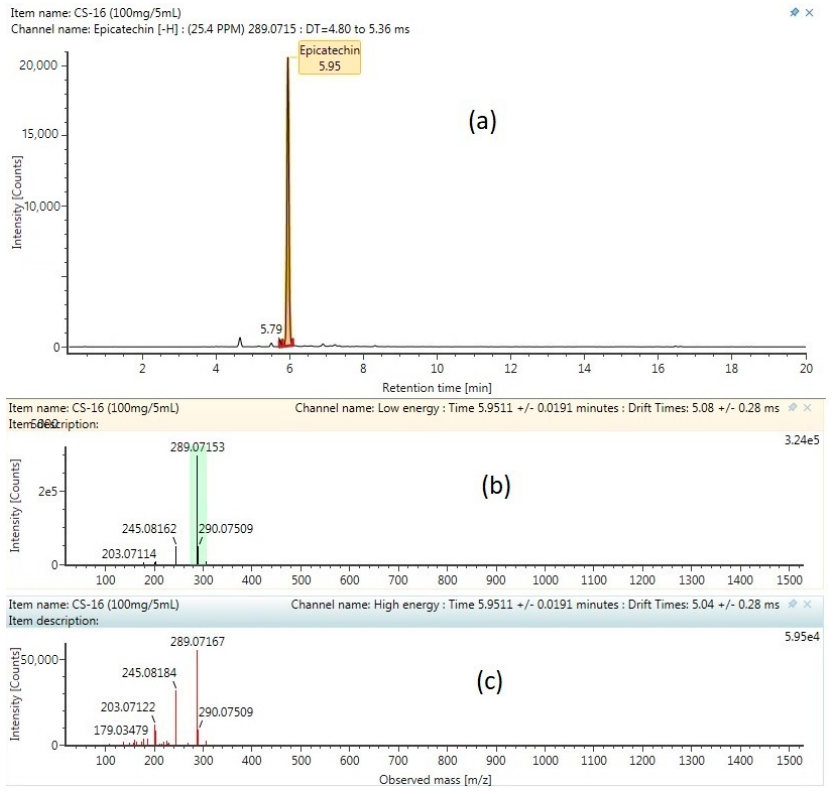
Figure 5. Malaysian cocoa shell extract (MSCE) negative ion mode of epicatechin compound: ( a ) chromatogram mass spectrum; ( b ) low energy of mass spectrum; ( c ) high energy of mass spectrum.